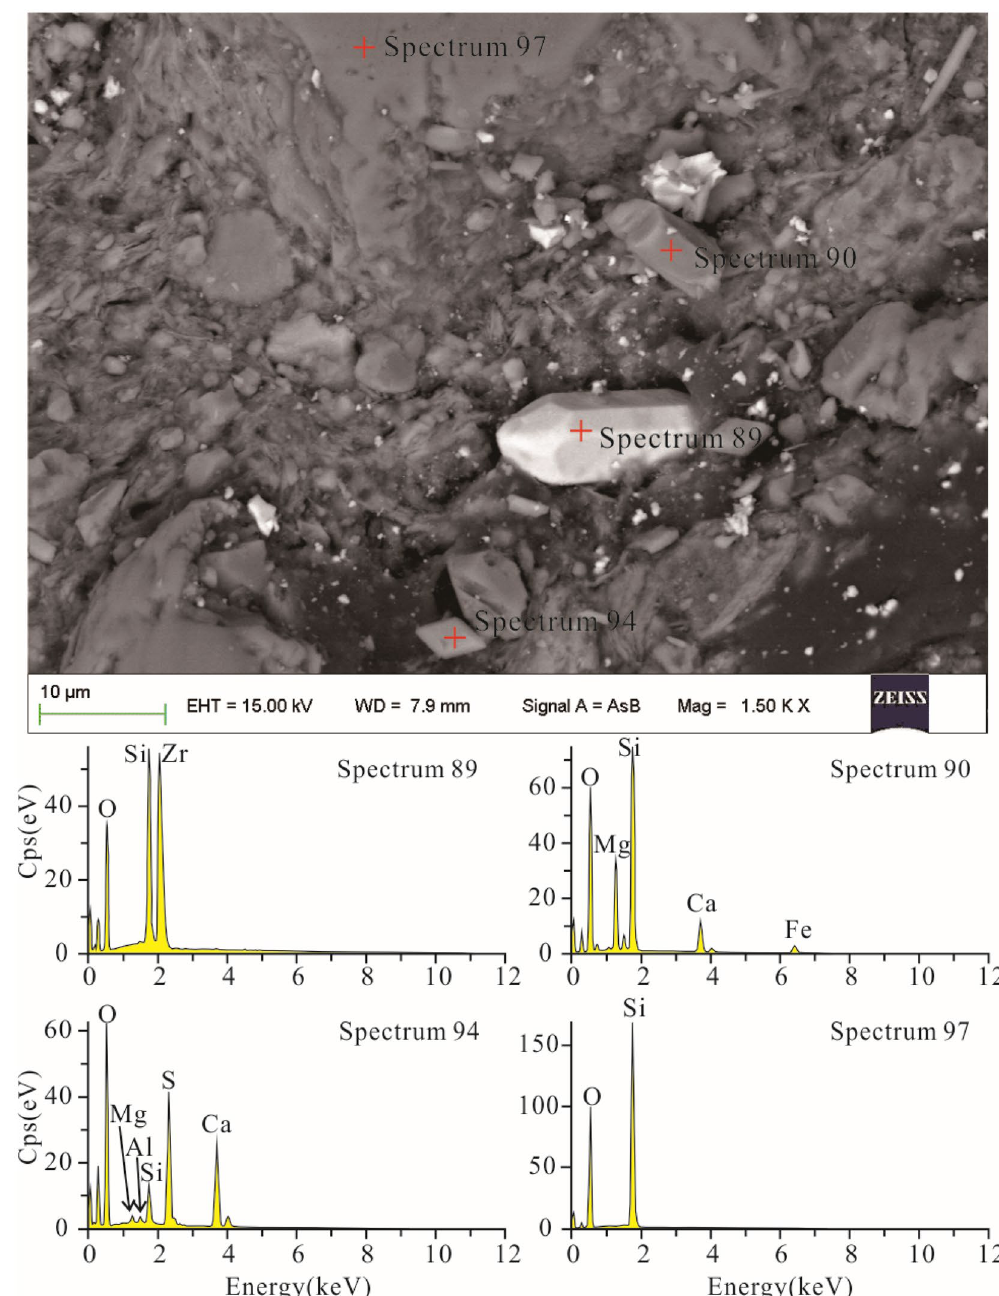
Figure 7. Electron microscope image and energy spectra of zircon, gypsum, quartz, and clinopyroxene in sample